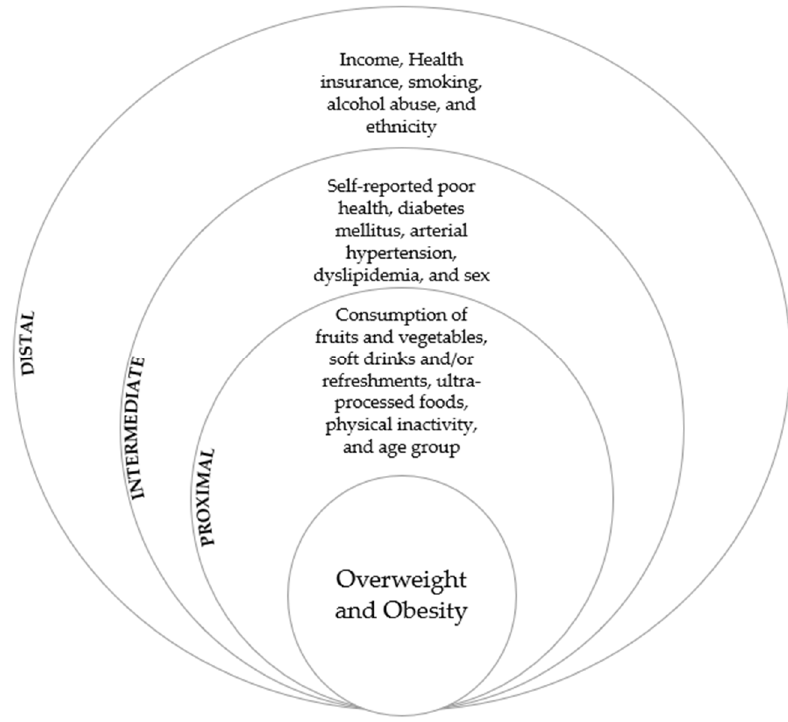
Figure 2. Hierarchical conceptual model for overweight and obesity.